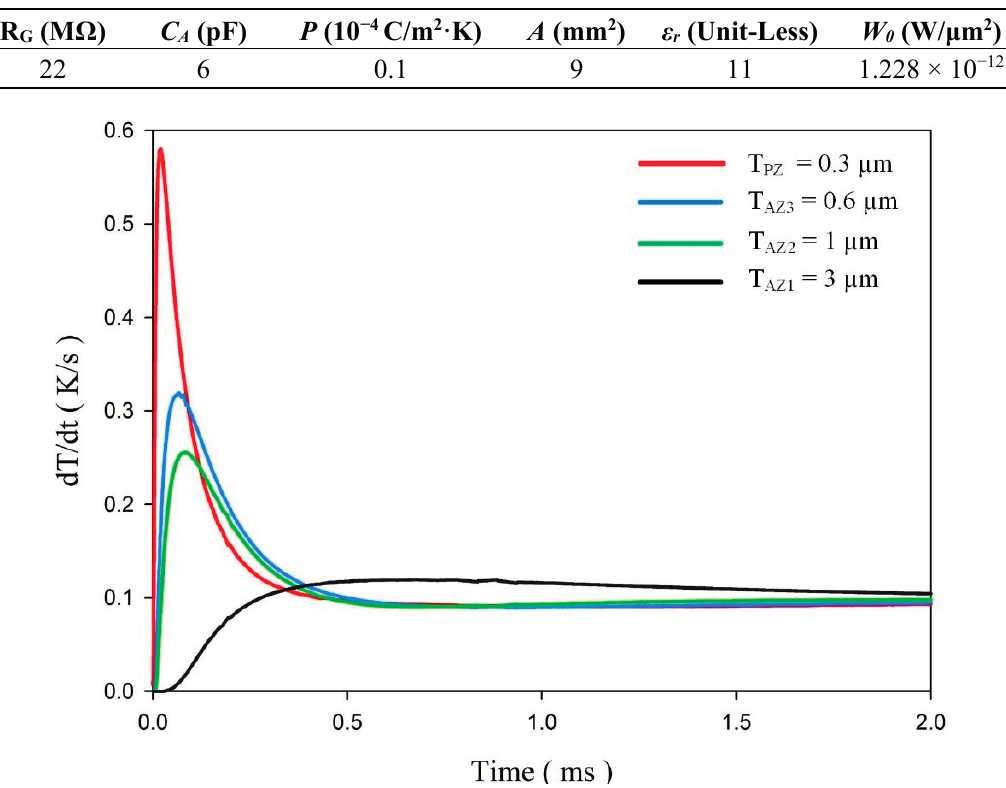
Table 5. Relative conditions for calculating Rv .